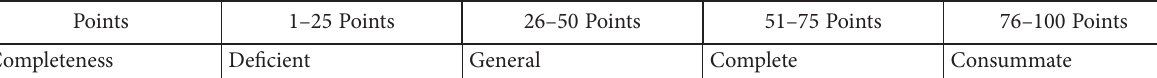
Table 4. Quantification of the completeness of relevant laws and